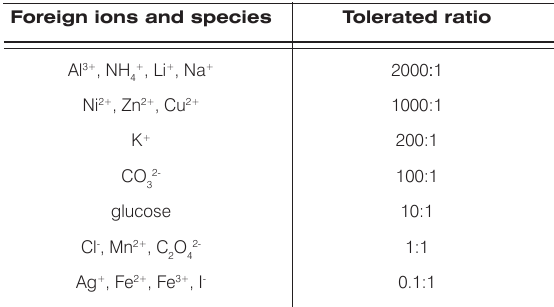
Figure 2. Influence of the concentrations of (a) Sulfuric acid; (b) [CuL] (ClO hydrochloride perturbed oscillation system. Common conditions: T = 18.3±0.5 º C. [VB [malic acid] = 0.18 M, [CuL] (ClO [H Table 1. Influence of Foreign Ions and Species on the Determination of 2×10 -5 M Pyridoxine Hydrochloride. Foreign ions and species Tolerated